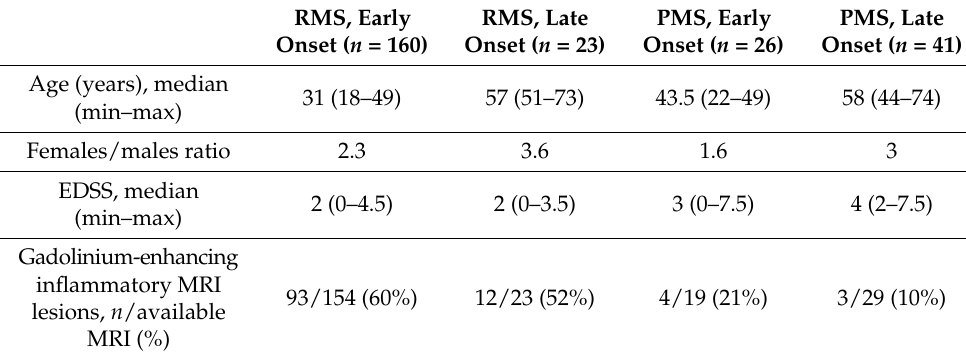
Table 1. Demographic and clinical